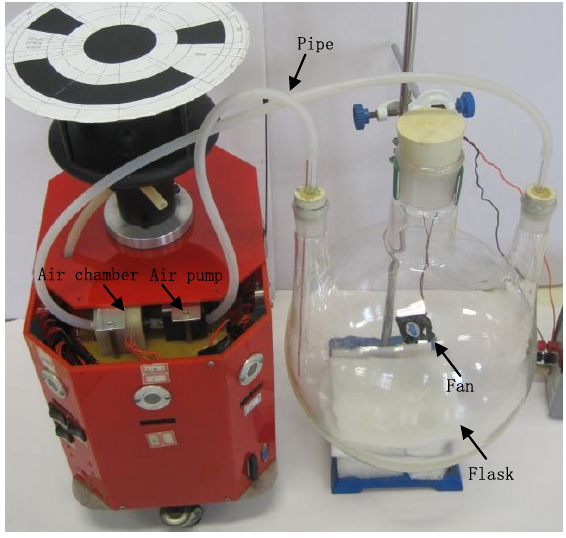
Figure 9. The device for gas sensor calibration. A TGS2620 gas sensor was mounted inside the air